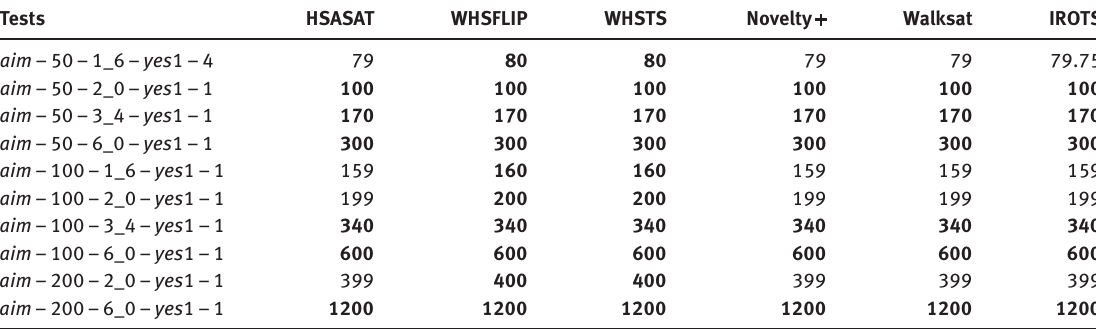
Table 4: Comparative Results